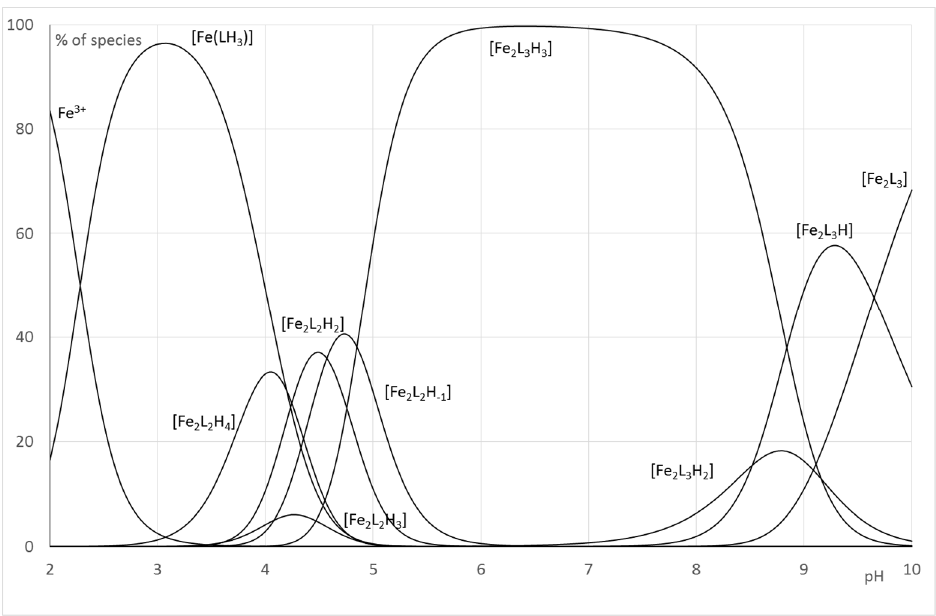
Figure 8. Distribution curves for the Fe- 1 systems (C L = 1.10 −3 mol.L −1 ; Cm = 2.10 −4 mol.L −1 ).